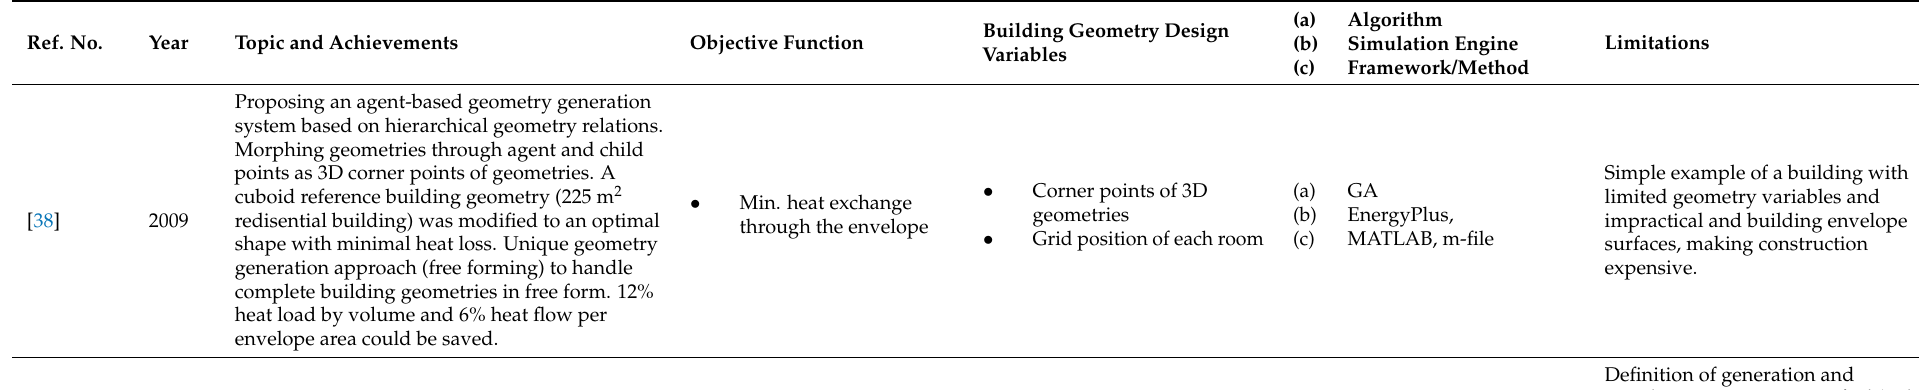
Table 2. BECEDO research using advanced building shape design